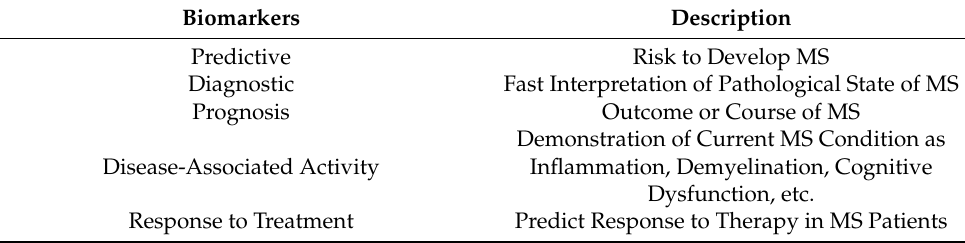
Table 1. Classification and clinical uses of